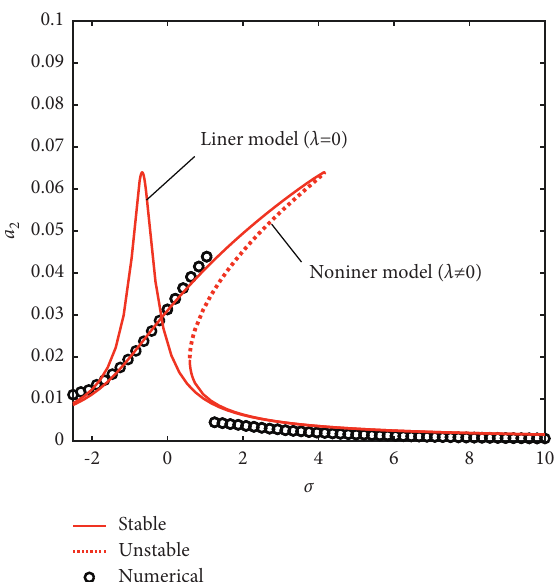
Figure 41: Comparison of results between the method of multiple scales and the numerical simulation (case II, L/d � 10, c � 0.03, θ � 0 ° , Ω � � 100, K f